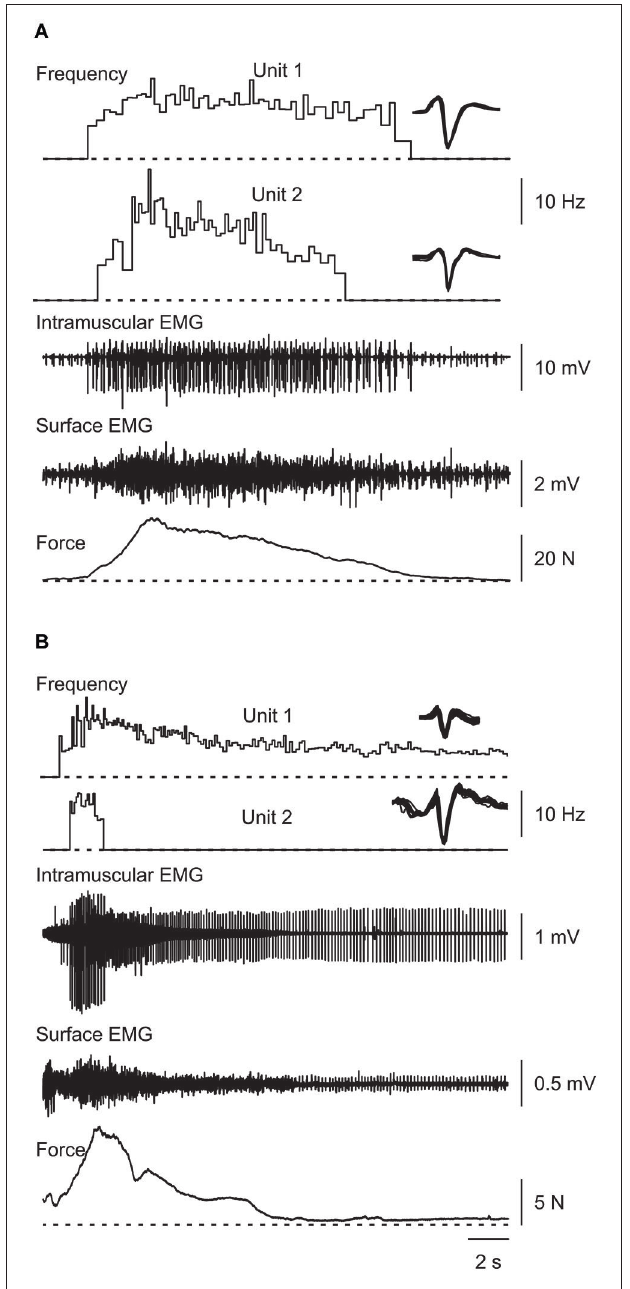
FIGURE 1 | Typical muscle spasms showing two motor units that are recruited, increase their firing rate during the force rise, decrease firing rate as the force declines, and are derecruited (A,B) or continue to fire after the contraction (B) . Overlays of the marked potentials show accurate identification of each motor unit